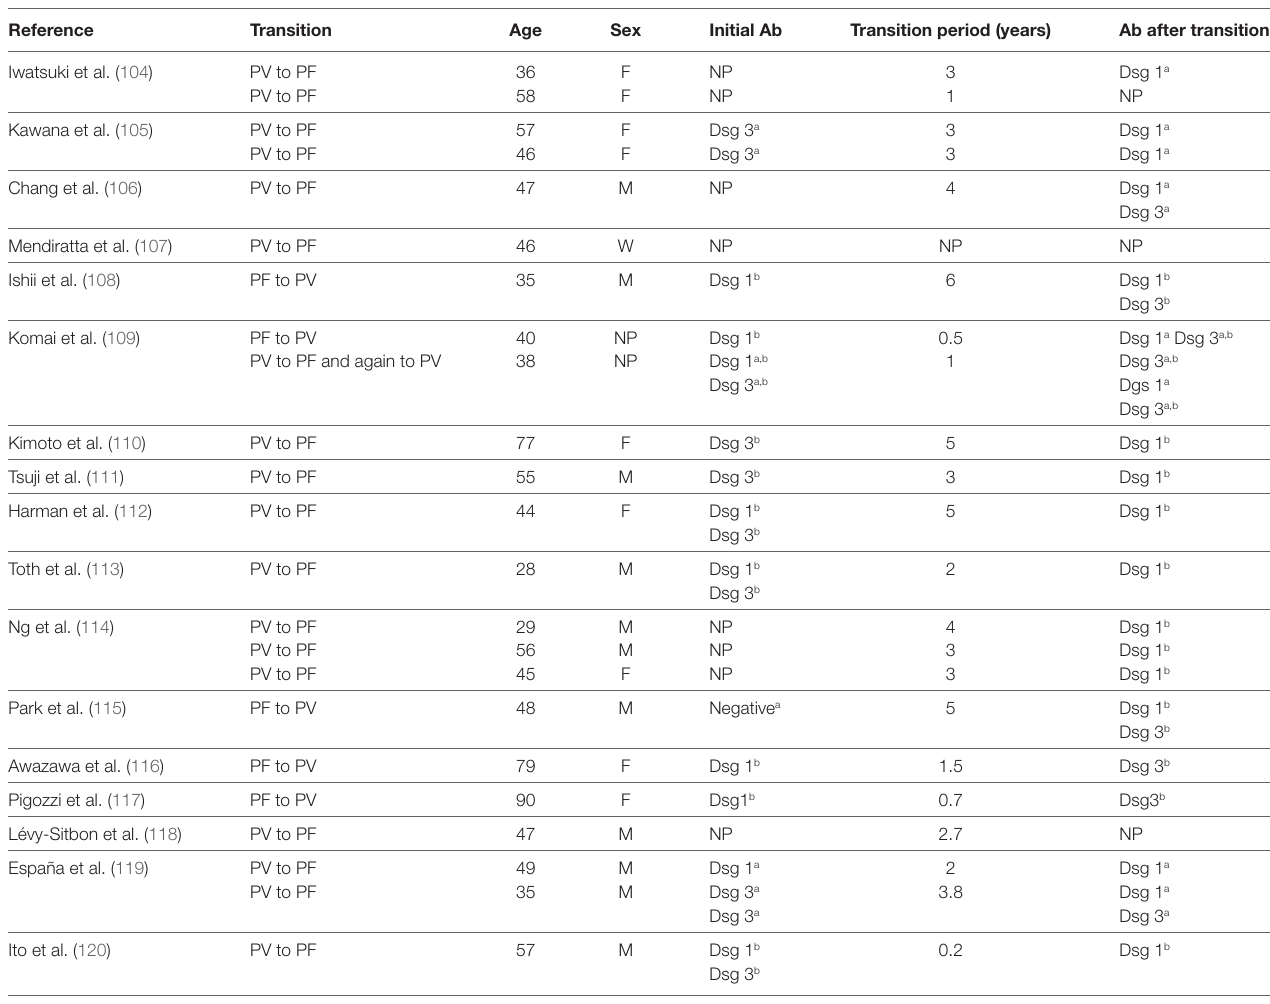
TABLe 1 | Cases of pemphigus with clinical shifting between PF and